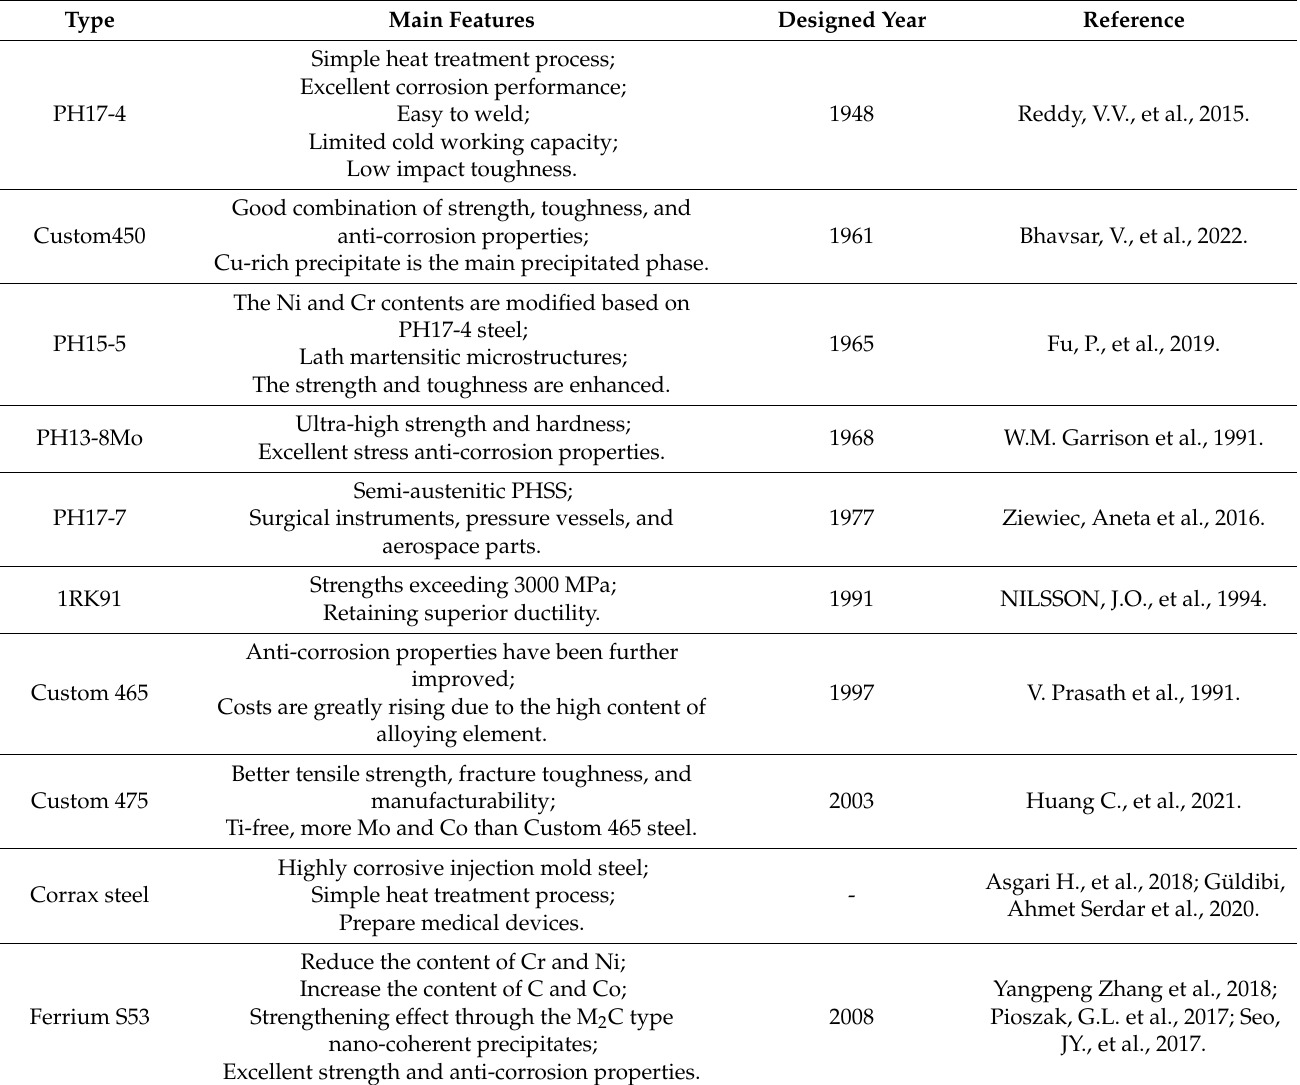
Table 1. The main features of typical precipitation hardened stainless steels with developed year